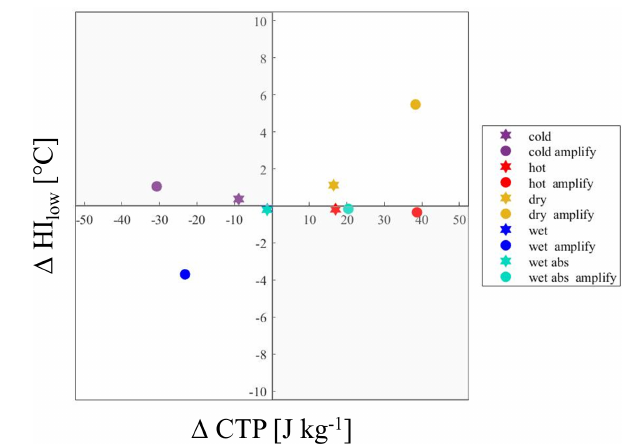
Figure 10. Changes in convective triggering potential (CTP) and low-level humidity index (HI low ) due to the divergence